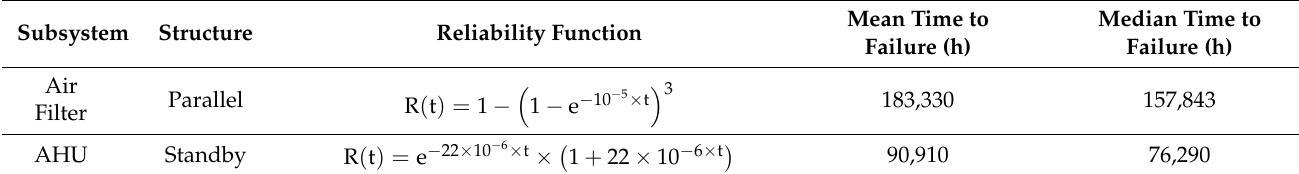
Table 7. The MTTF and Median time to failure of the air filter and the